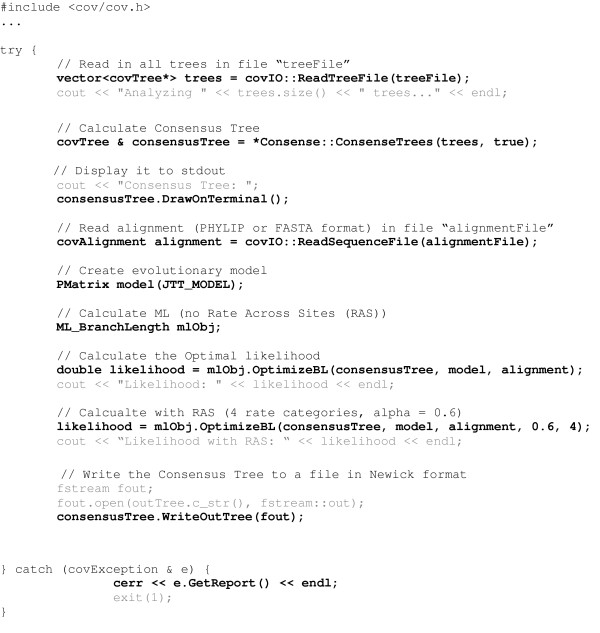
The likelihood of a consensus tree. In this example, a file containing trees in NEWICK format is parsed and a consensus tree is resolved using the greedy majority-rule consensus algorithm [9, 21]. Finally, the likelihood of the resulting tree is calculated. Bolded lines are libcov API calls.